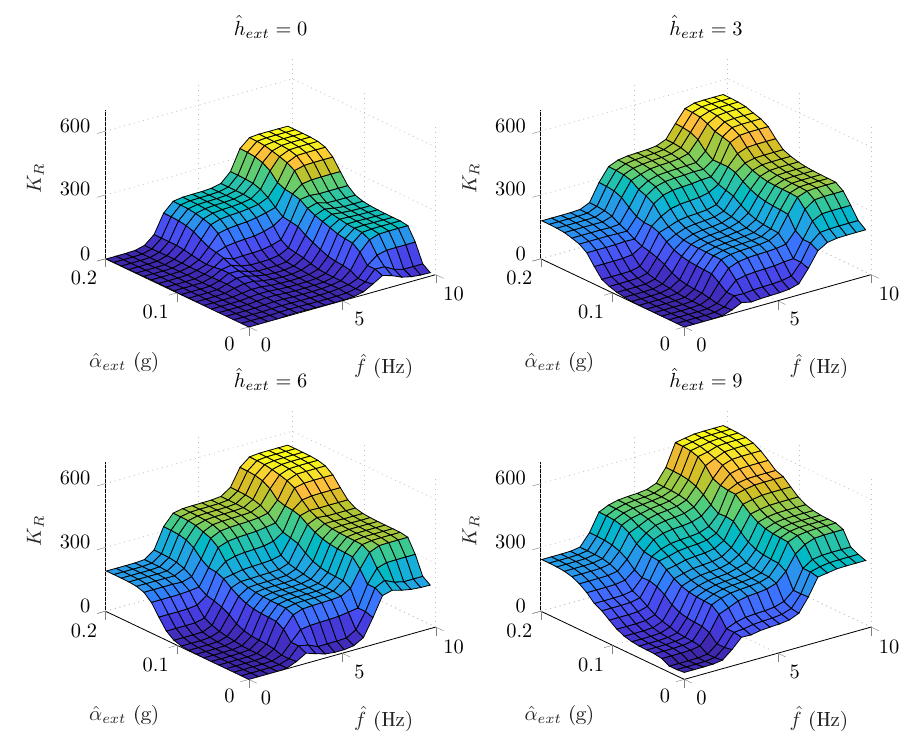
Figure 4. Generated surfaces related to the fuzzy rule base. Table 1. Rule base of the fuzzy inference